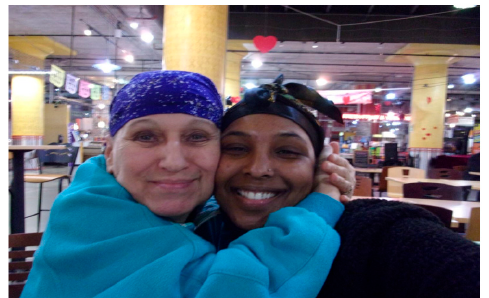
Figure 10. “ In this image, my granddaughter and I are sharing an embrace.”